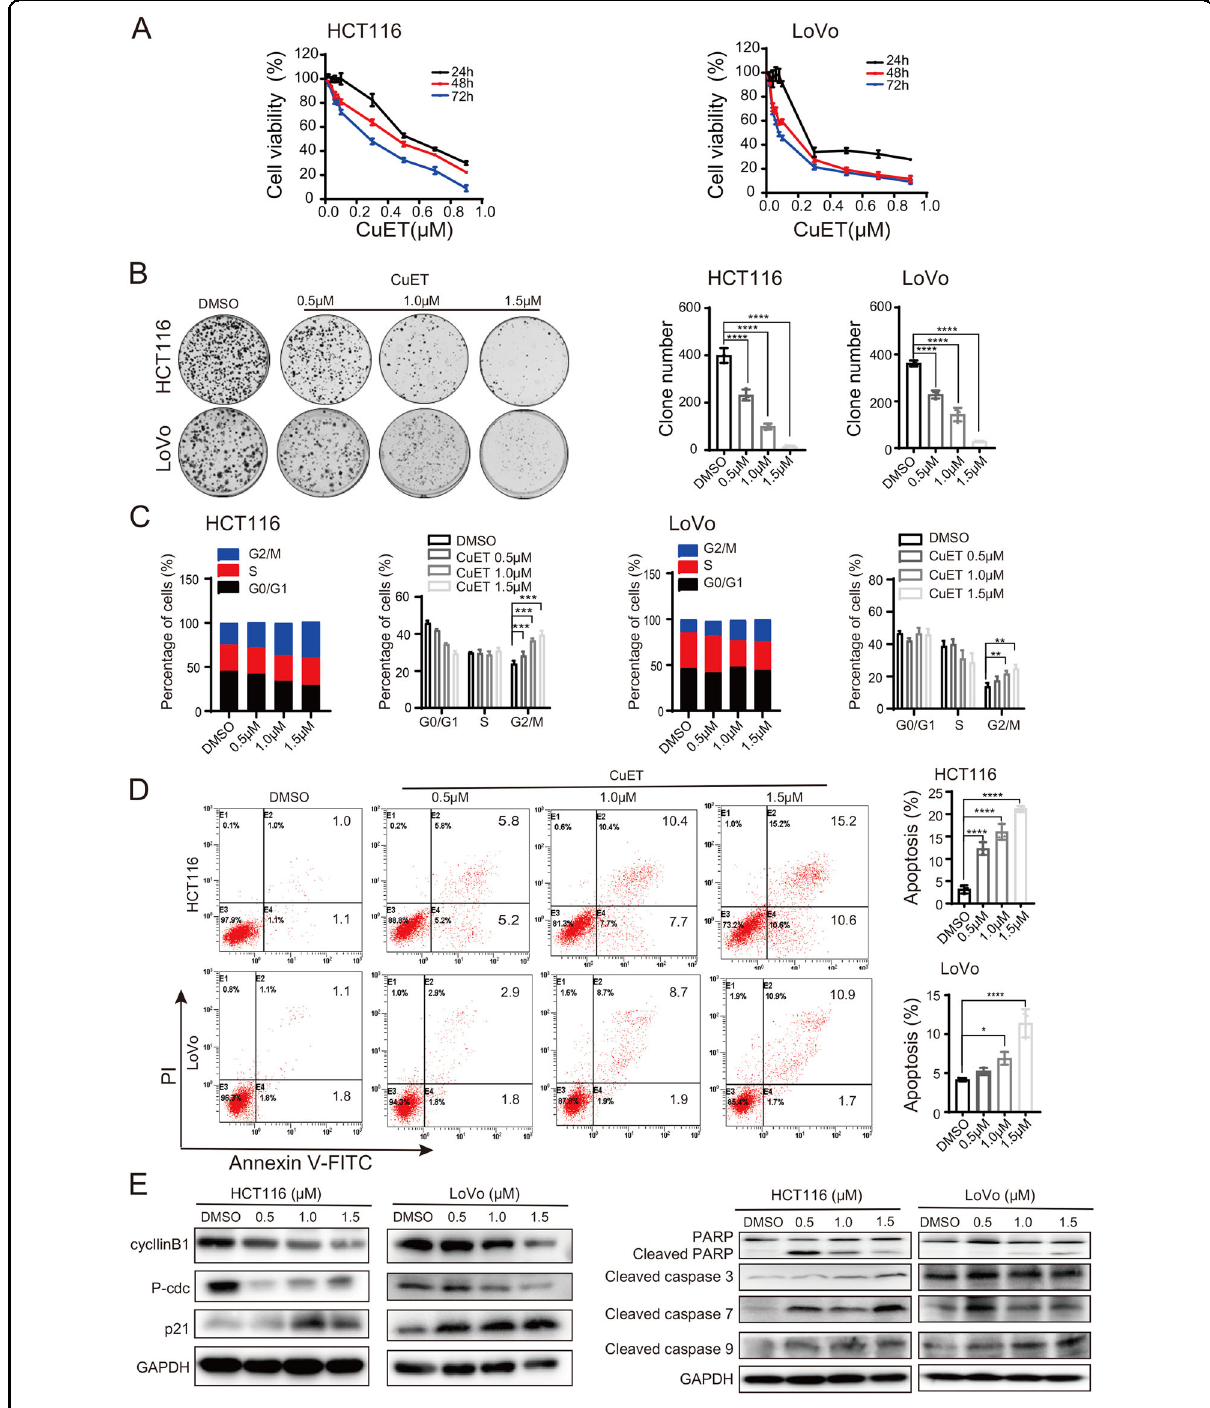
Fig. 1 Effects of CuET on cell viability, cell cycle distribution, and apoptosis of CRC cell lines. a HCT116 and LoVo cells were incubated with different concentrations of CuET for 24 h, 48 h, or 72 h, and the cell viability was determined. b HCT116 and LoVo cells were treated with different concentrations of CuET (0.5 μ M, 1.0 μ M, 1.5 μ M) or DMSO for 24 h, respectively; cells were then seeded as single cells and grown in drug-free medium for 14 days. Colony formation assay was carried out by crystal violet staining. The number of colonies was shown at right panels. c , d HCT116 and LoVo cells were treated with different concentrations of CuET; the cell cycle distribution ( c ) and apoptosis ( d ) were analyzed by fl ow cytometry. e Western blot of cyclin B1, P-cdc, P21, PARP, and cleaved PARP, cleaved caspase 3, caspase 7, and caspase 9 from HCT116 and LoVo cells treated with different concentrations of CuET and the controls. Data in a – d are shown as the mean ± SD from three independent experiments, * p < 0.05, ** p < 0.01, *** p < 0.001, **** p <